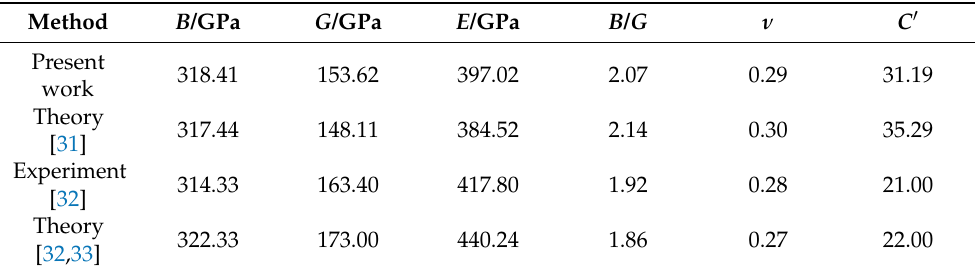
Table 2. Bulk modulus ( B ), shear modulus ( G ), Young’s modulus ( E ), B / G ratio, Poisson’s ratio ( ν ) and Cauchy pressure ( C (cid:48) ) of pure